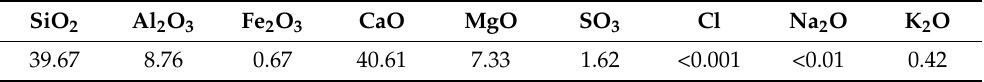
Table 4. Chemical composition of the granulated ground blast furnace slag used in the study [% by weight].